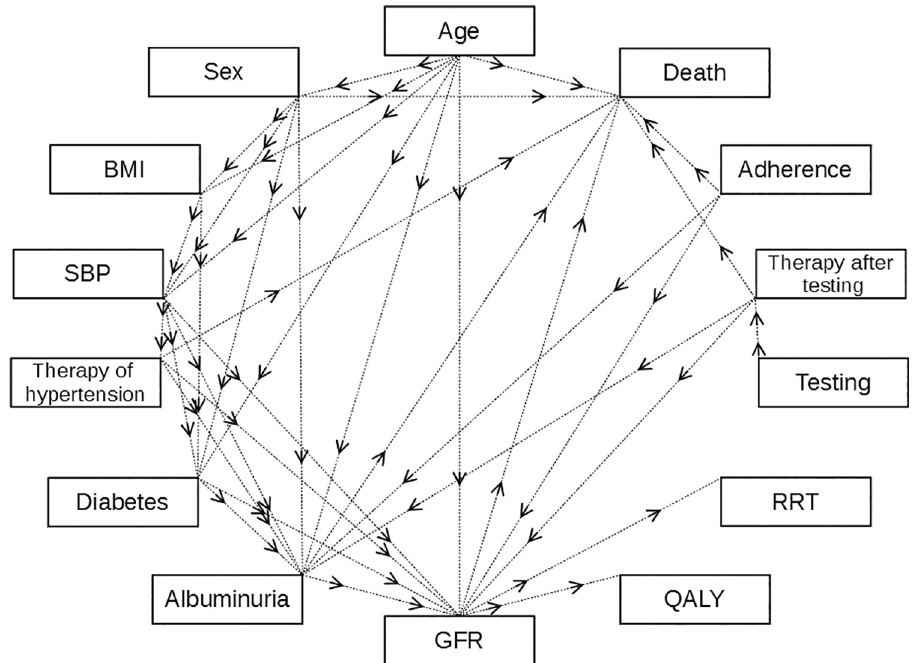
Fig 1. Overview of modeled health parameters and direct